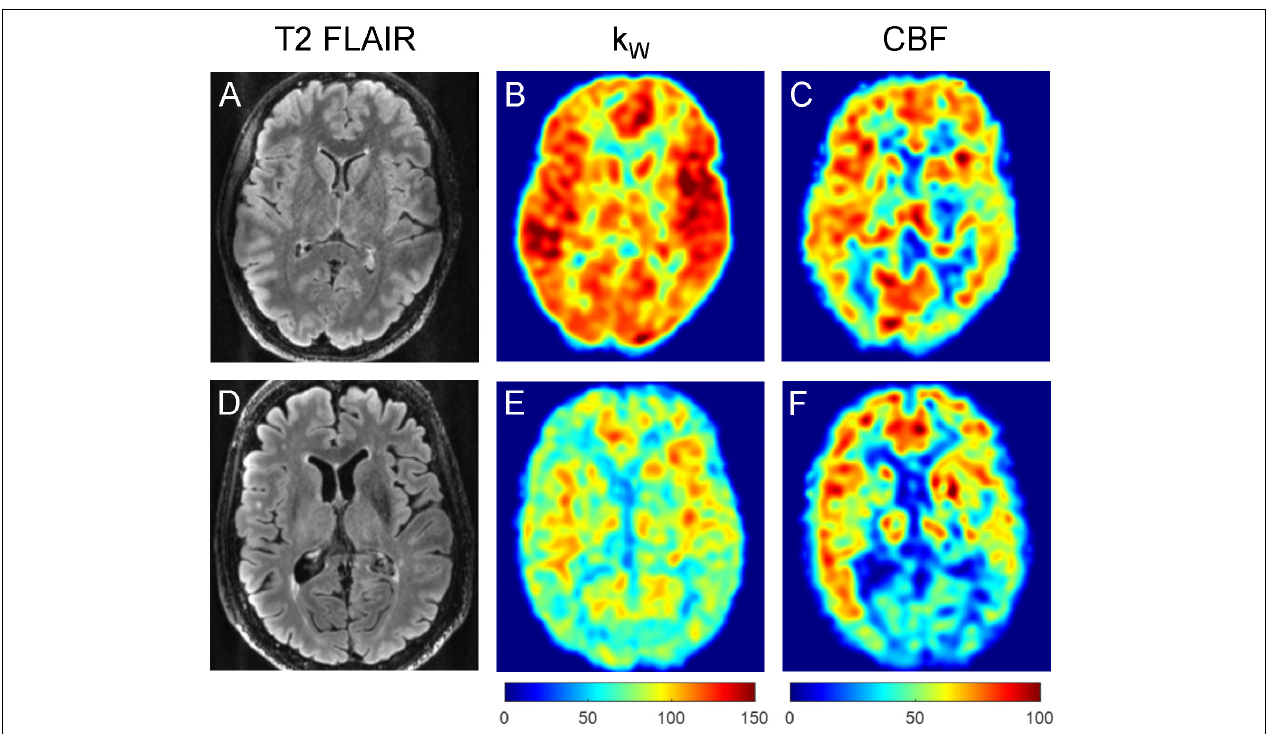
FIGURE 3 | Representative T2-FLAIR images (A,D) , k W maps (B,E) , and CBF (C,F) maps obtained from a 32-year-old subject with no vascular risk factors (A–C) and a 77-year-old subject with one vascular risk factor (former smoker, 40 pack-year) (D–F) . The younger subject demonstrated mean cortical k W of 108.1 min − 1 , mean white matter k W of 97.4 min − 1 , mean cortical CBF of 60.1 mL/100 g/min, and mean white matter CBF of 48.6 mL/100 g/min. The older subject demonstrated lower mean cortical k